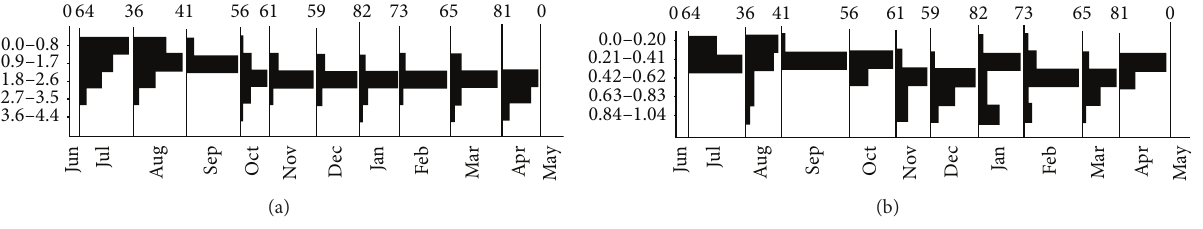
Figure 3: Size frequency distribution of (a) body length (mm) and (b) head width (mm) of Baetis sp.